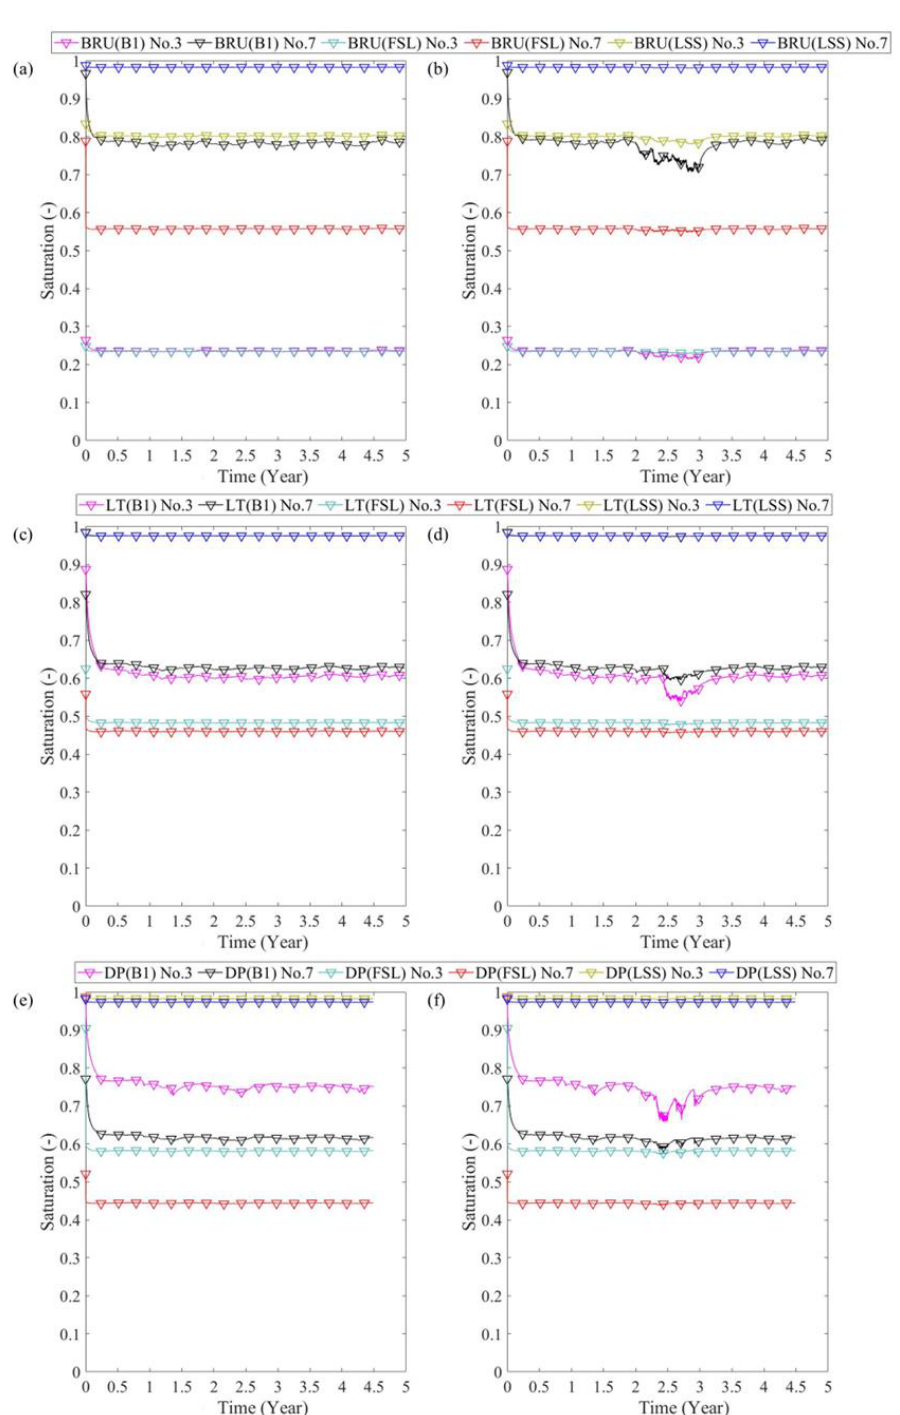
Figure 12. Saturation changes at middle cable: BRU location ( a ) normal loading ( b ) overloading; LT location ( c ) normal loading ( d ) overloading; DP location ( e ) normal loading ( f ) overloading.